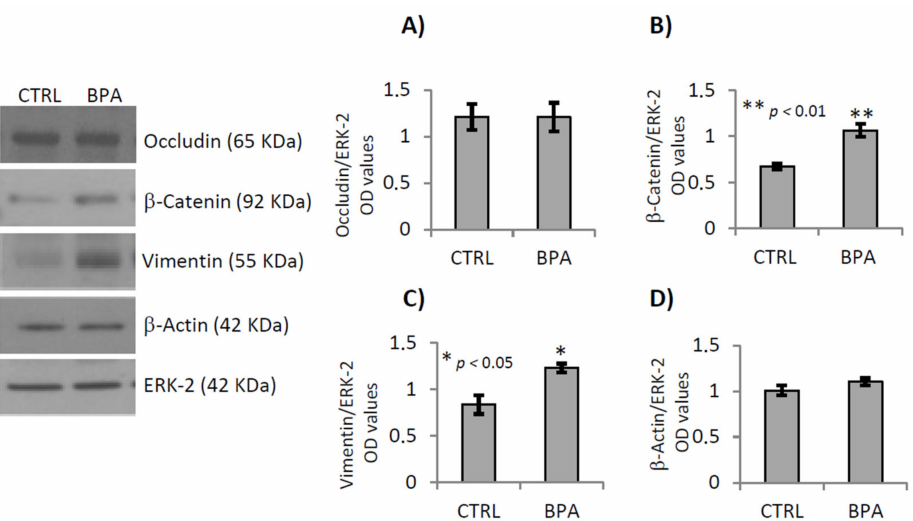
Figure 8. Gene expression analysis of some proteins organizing or modulating cell–cell junctional complexes in testis of male mice early-life exposed to vehicle (CTRL, n = 3/4) or BPA (BPA, n = 4) and sacrificed at 78 dpp . Western Blot analysis of occludin, β -catenin, vimentin and β -actin. Protein amounts were quantified by densitometry analysis, normalized against ERK-2 signals, and expressed in OD values as fold change ( A – D ). All data were reported as mean value ± S.E.M. (*: p < 0.05; **: p <